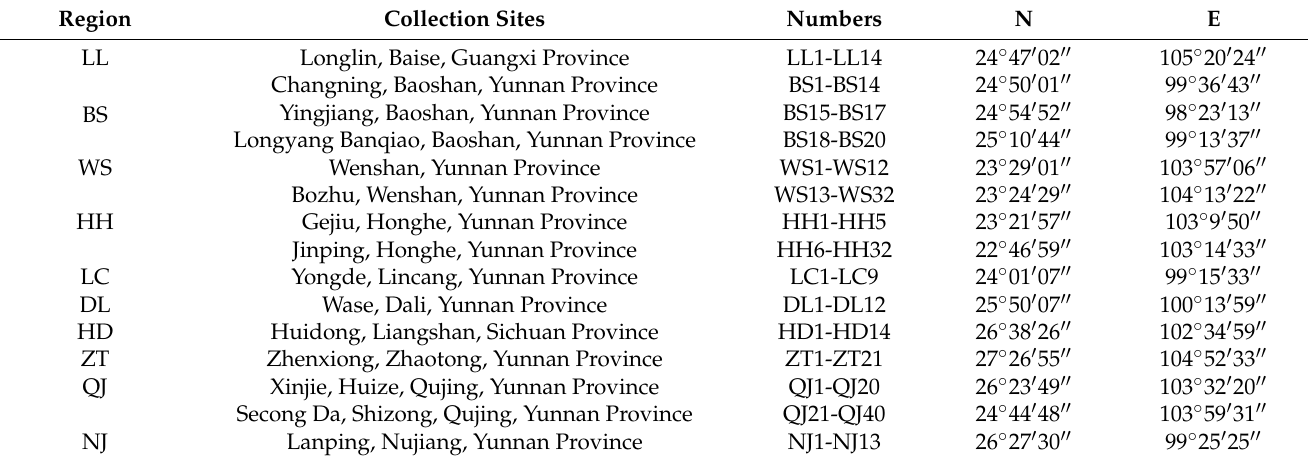
Figure 1. Basic information (plant, habitat and rhizome) and sampling location of Polygonatum kingianum . Table 1. The specific sampling information of Polygonatum kingianum.